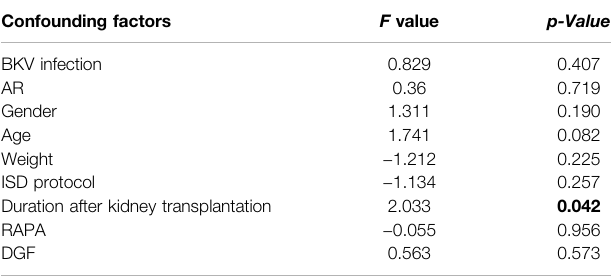
TABLE 2 | In fl uence of confounding factors on the outcomes of proteinuria by a general linear model in this cohort.